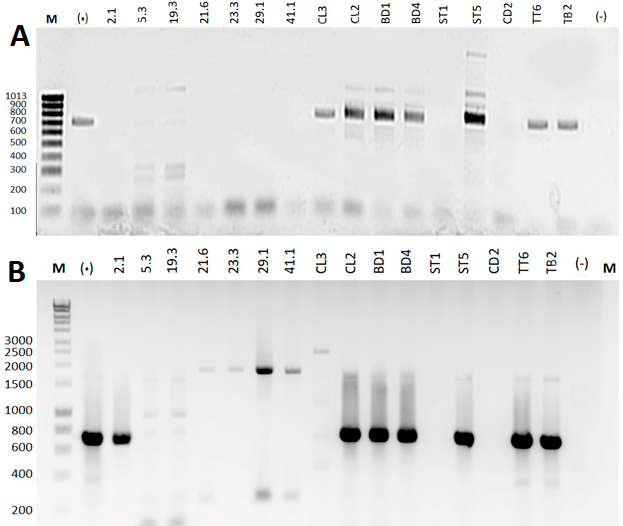
Figure 2. PCR amplification of Vi+ genomes for biosynthetic gene clusters of ( A ) NRPS using primer (A3F/A7R) and ( B ) PKS-I using primer (MDPQQR_f/HGTGT_r). Lanes, from left to right (M), included hyperLadder™ 100 bp (Bioline Reagents Limited, London, UK), positive control (+), followed by gene products amplified from seven sponge-associated Vi+ genomes (labeled with number code) and nine intestinal Vi+ genomes (labeled with letter–number code), and a negative control (-).